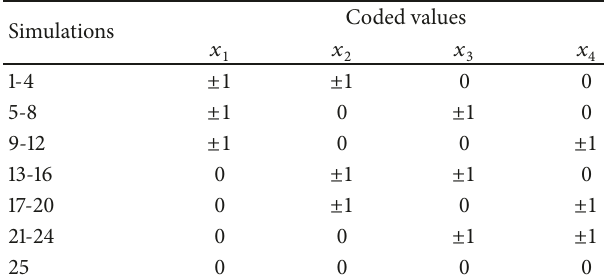
Table 2: Tabulated simulations in a Box-Behnken experimental design with 𝑘 = 4